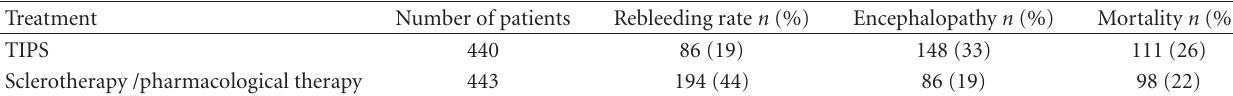
Table 5: Comparison of TIPS and endoscopic and/or pharmacological therapy in the prevention of oesophageal variceal rebleeding (from Zheng et al. [59]).